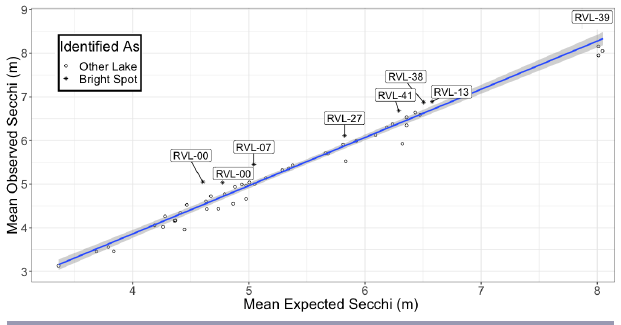
Fig. 3 . Eight bright spot sites (of 53) on seven lakes (of 39) and nine dark spot sites on eight lakes designated from model